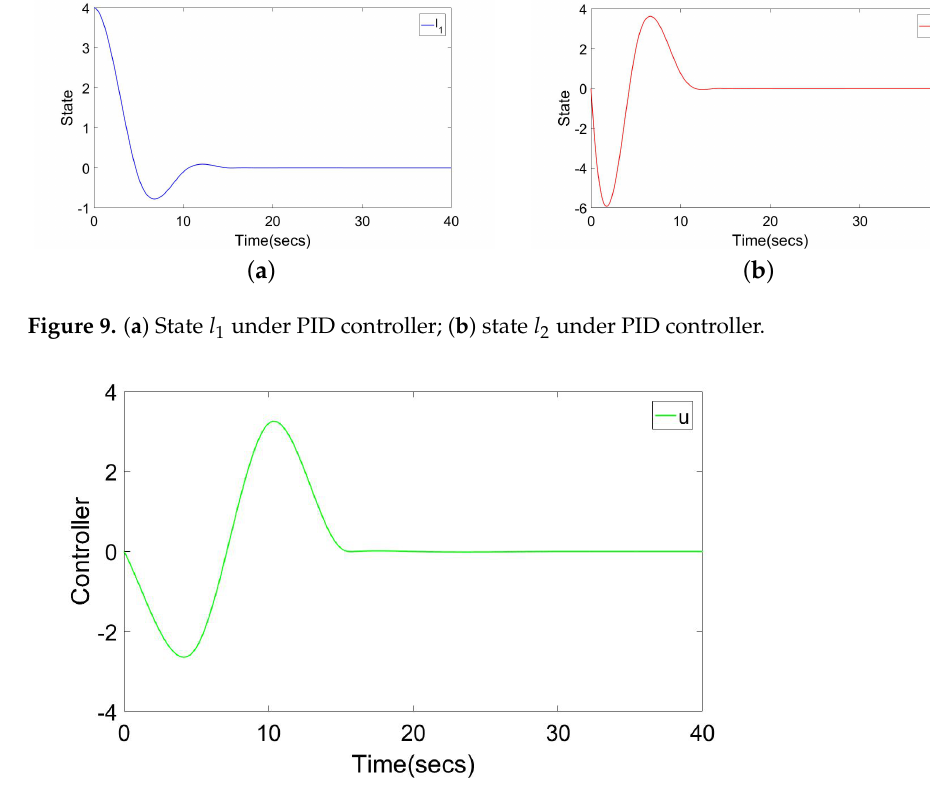
Figure 10. Controller u under PID